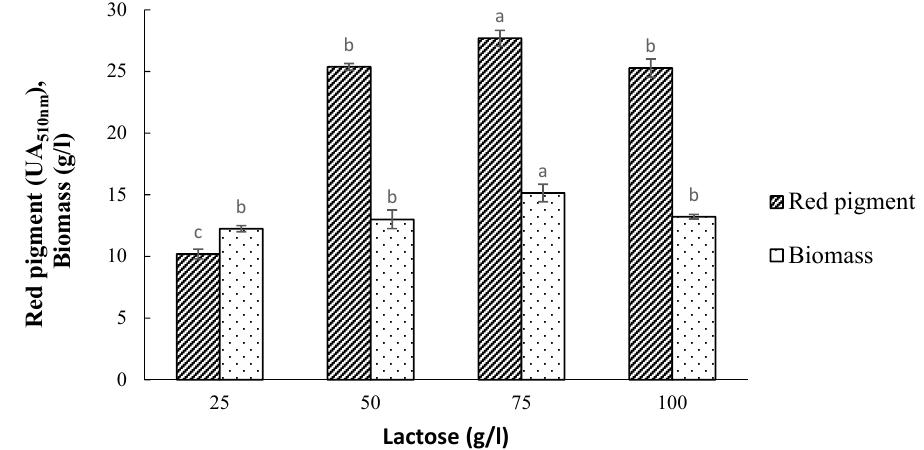
Figure 4. The effect of initial lactose concentration on red pigment and biomass production by M. purpureus CMU 001 (Fermentation conditions: 30 °C, 8 days, 200 rpm, pH 7.0, 5 g/L MSG).